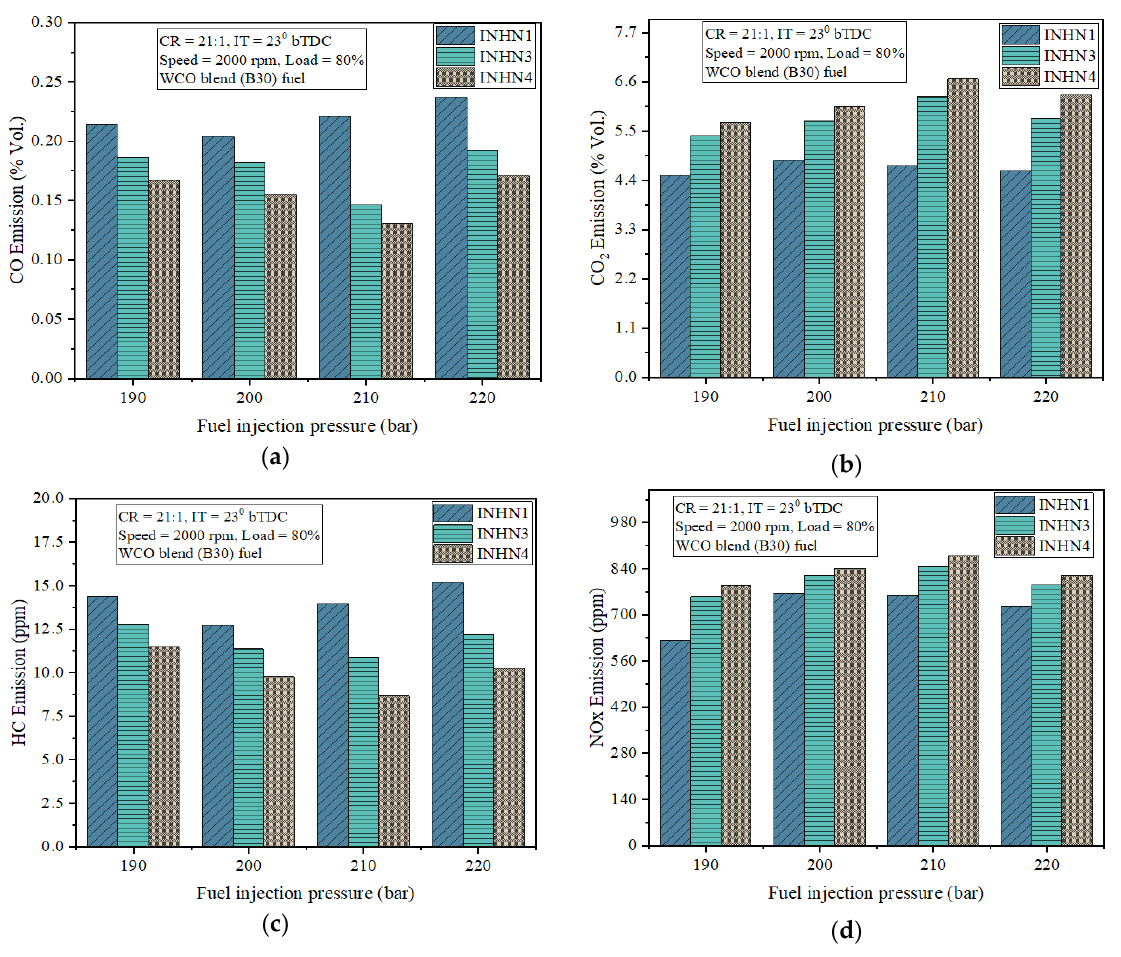
Figure 17. Effects of fuel IPs and INHNs on: ( a ) CO; ( b ) CO 2 ; ( c ) HC, and ( d ) NOx emissions from en- gine.